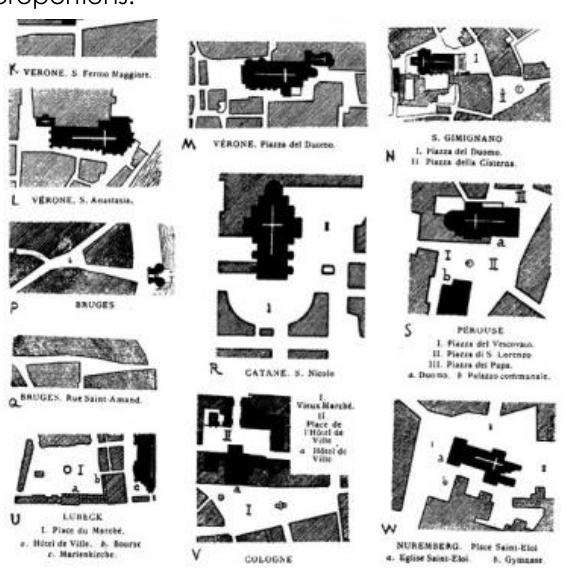
Figure 4. Camillo sitte and the organization of public buildings around the squares.